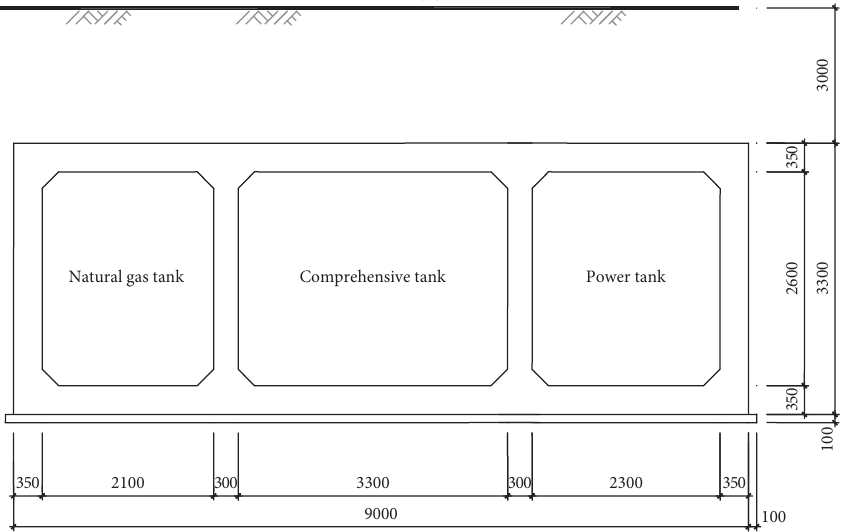
Figure 4: Standard cross-sectional profile of utility tunnel (unit: